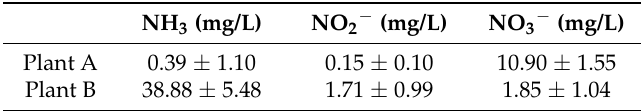
Table 2. Comparison of nitrogen concentration in two chlorine disinfection tank influents from two Southern California reclamation